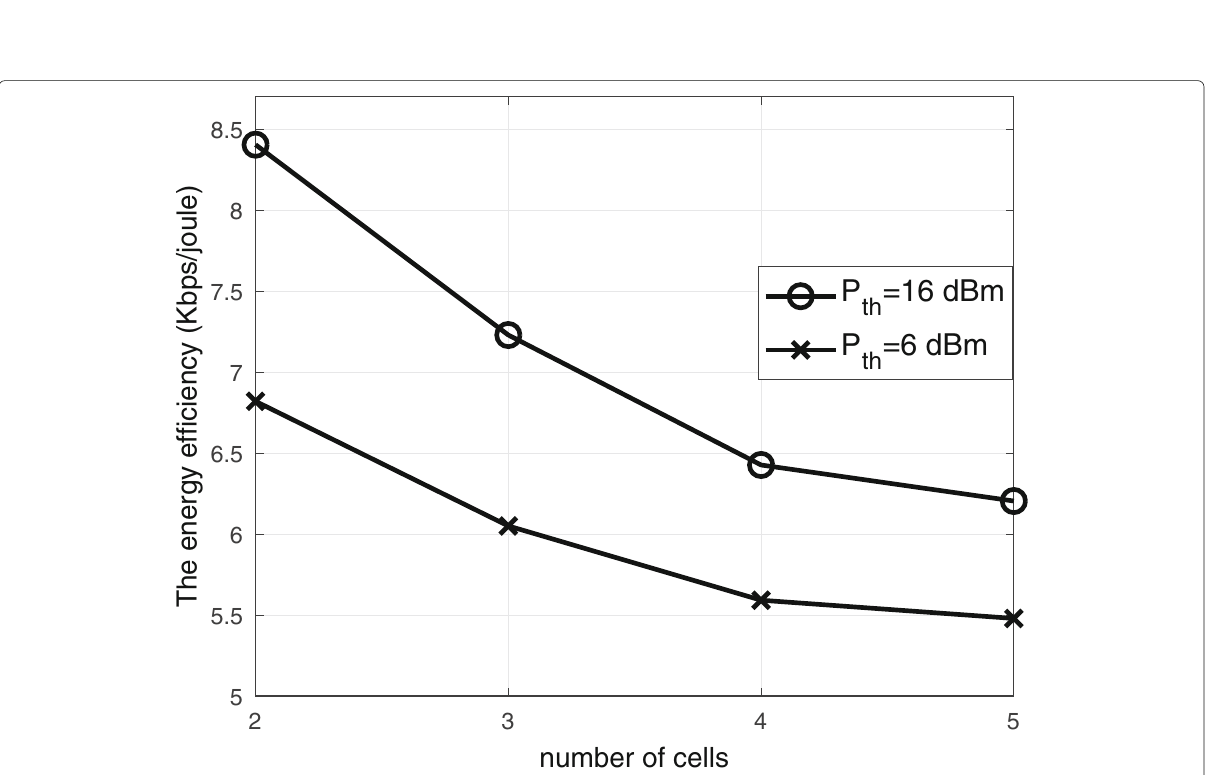
Fig. 10 Energy efficiency versus number of secondary cells. The performance of the proposed algorithm with different number of secondary